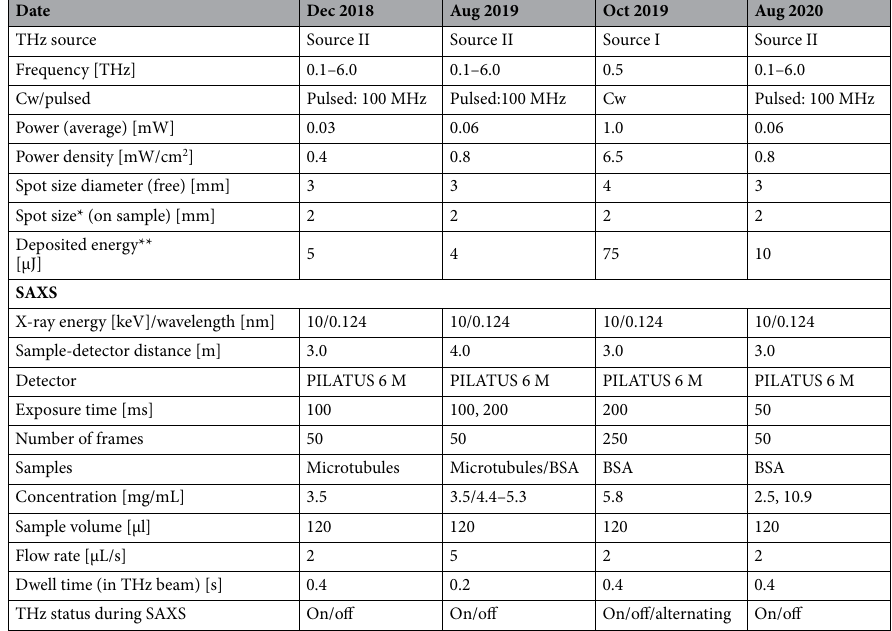
Table 1. Overview of the experimental parameters of the different THz-SAXS beamtimes. *Defined by sample cell aperture of w = 2 mm. **Taking into account the dwell time of the sample in the THz beam and the transmission of the PS